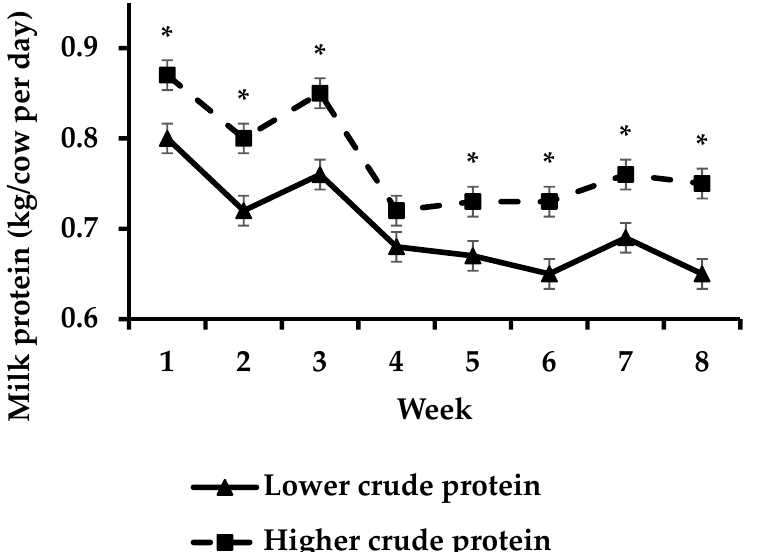
Figure 4. Effect of protein supplementation strategy × week on milk protein yield [asterisks (*) indicate a significant difference for week].